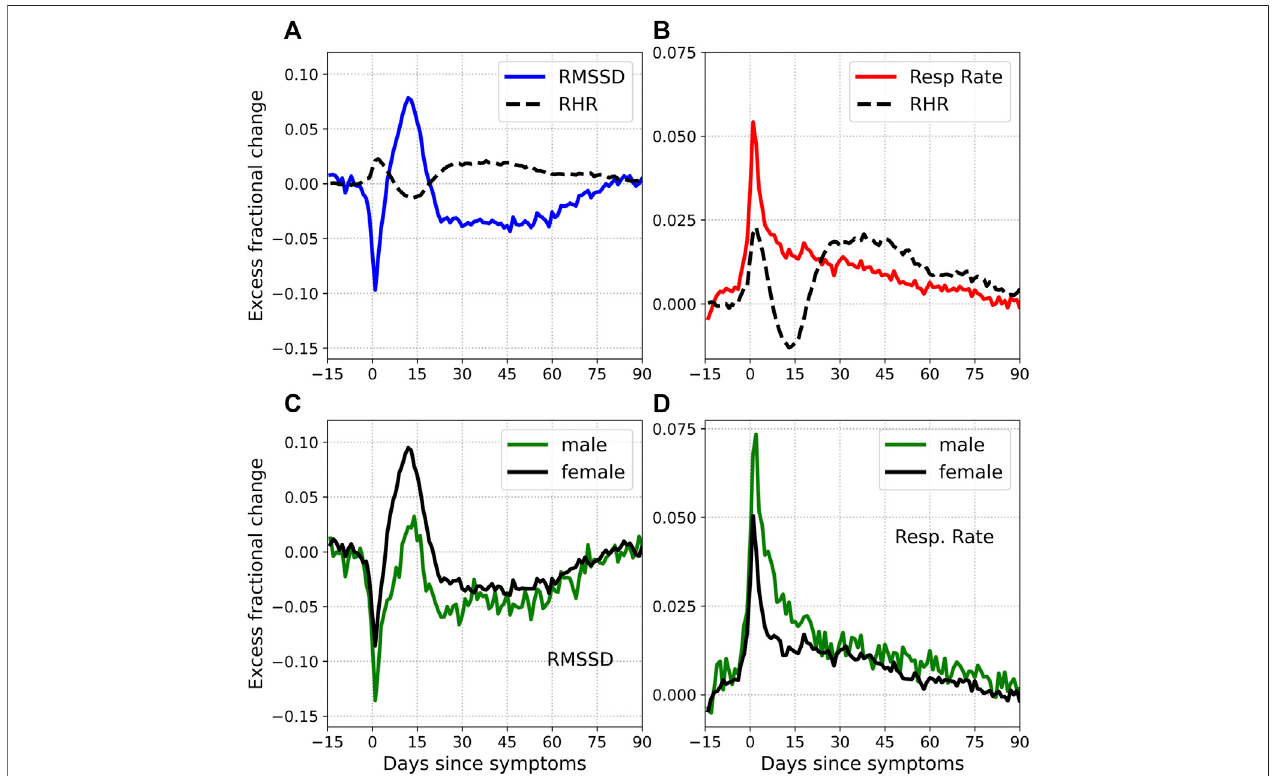
FIGURE 7 | Excess fractional change in RMSSD and respiratory rate. Subplots (A) and (B) also show the excess fractional change in RHR (dashed black lines). Note that the RHR waveform is smoothed over time, resulting in a more rounded peak. Subplots (C) and (D) show the RMSSD and respiratory rate for male (green) and female (black) subjects